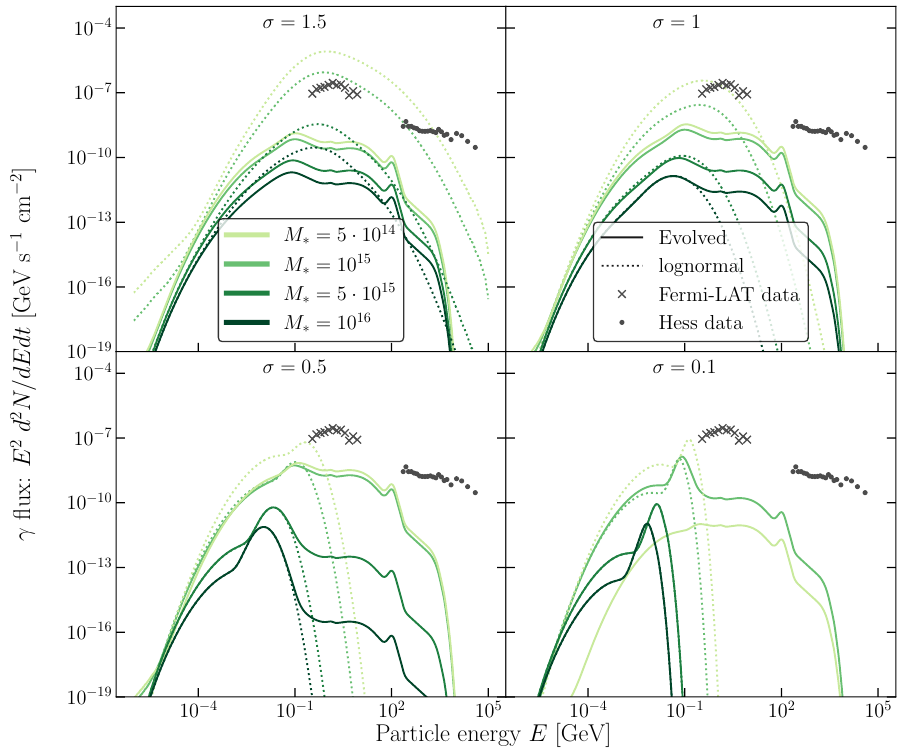
Figure 3: The expected gamma-ray spectrum from the galactic centre for sixteen extended distributions of varying mass and standard deviation with f alongside measured fluxes from HESS [ 28 ] (black dots) and Fermi-LAT data [ 29,30 ] (black crosses). The thick lines correspond to distributions correctly evolved as in Eq. 11, while the dotted lines correspond to a naive ‘unevolved’